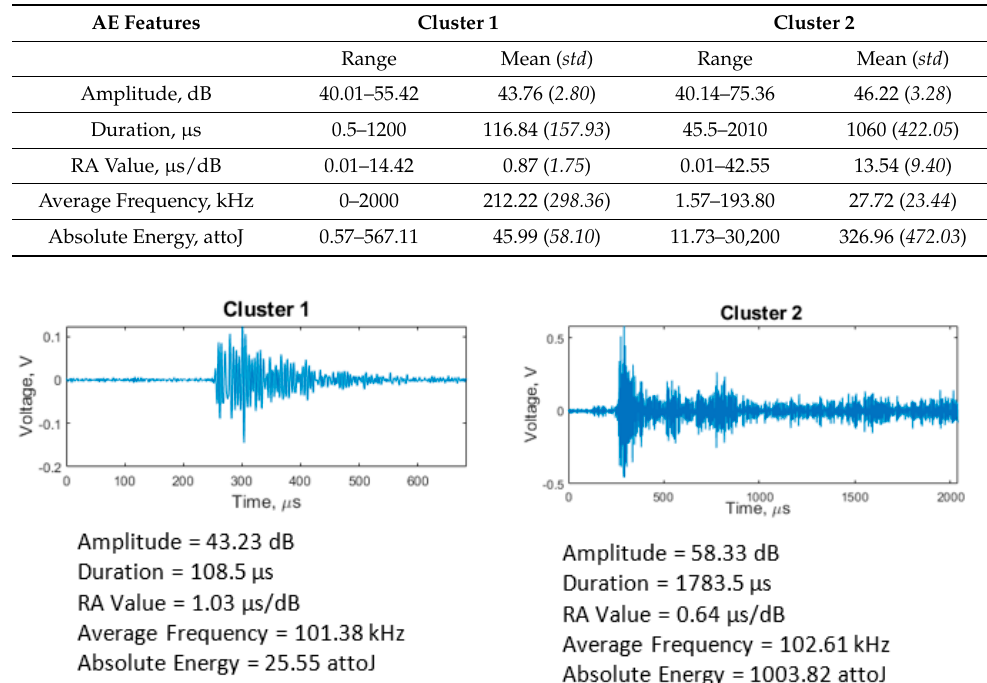
Figure 10. Waveform of abrasive clusters and their features. Event in cluster 1 is a burst emission, while that of cluster 2 is a mixture of continuous and burst emissions.